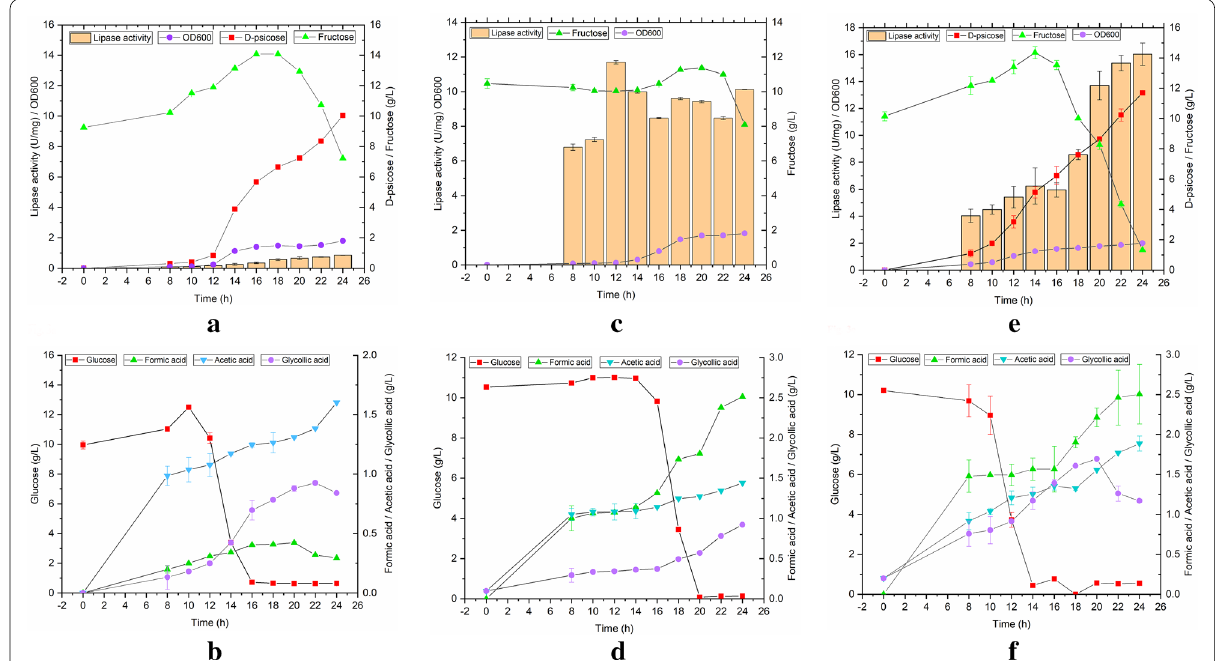
Fig. 3 Batch fermentation of engineered B. subtilis ( a , b ), E. coli ( c , d ), B. subtilis and E. coli ( e , f ) using fermentation